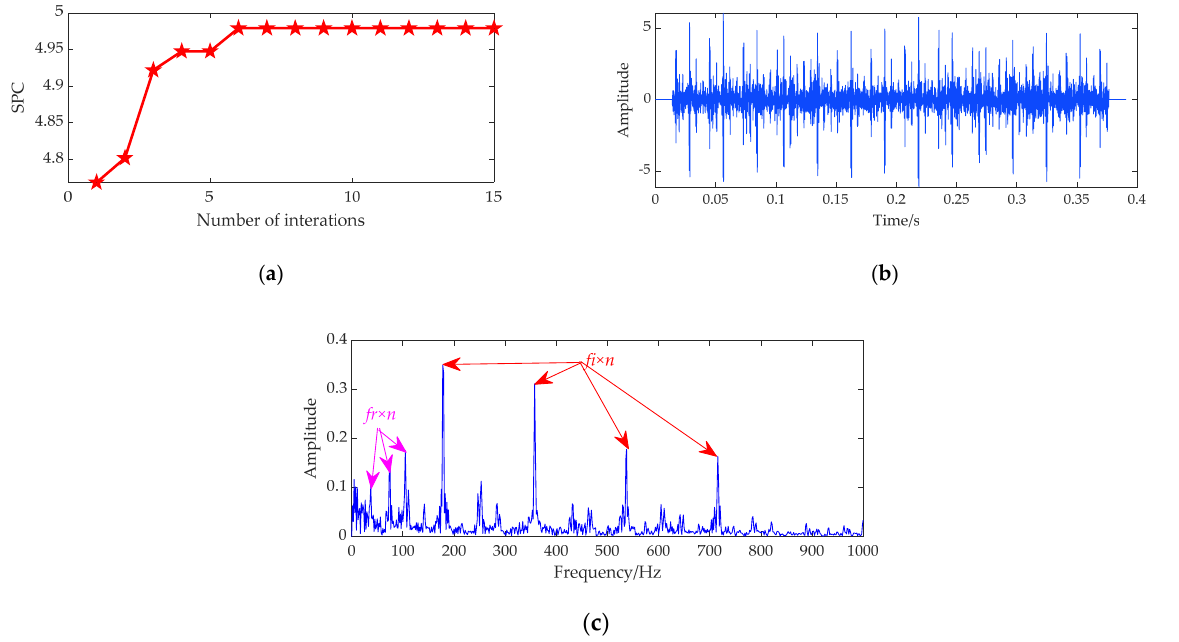
Figure 11. The results for modes 2 and 3 are processed by CLNGO-MNAD. ( a ) Convergence curve of SPC. ( b ) Time-domain waveform. ( c ) Envelope spectrum.